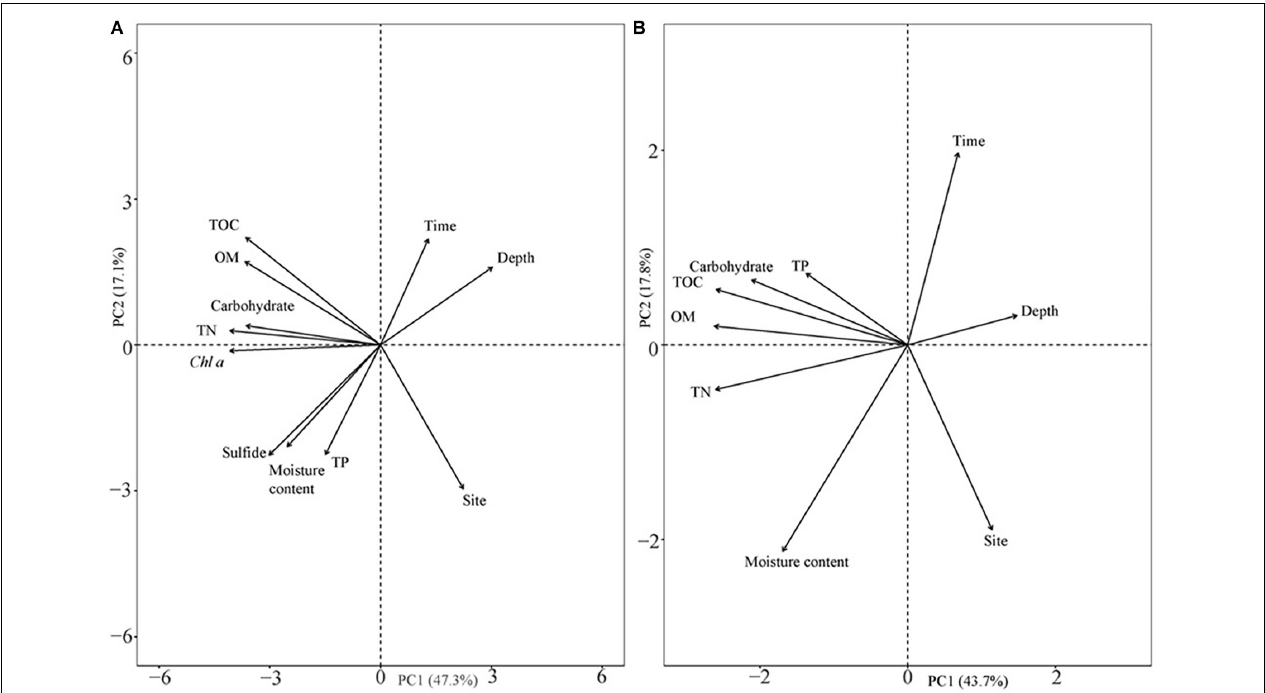
FIGURE 8 | Principal component analysis of sediment parameters in different seasons and their vertical distribution. (A) Eight sediment parameters in deep sediment cores with annual differences and different vertical distributions in two different years; and (B) six sediment parameters in shallow sediment cores with seasonal changes and vertical distribution at the two